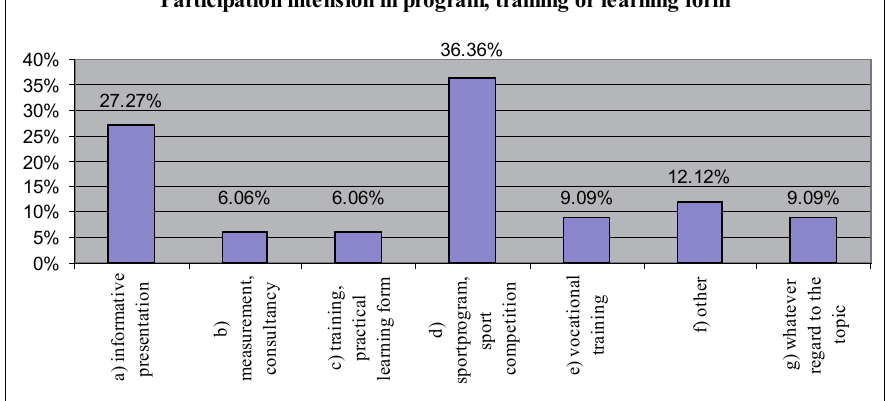
Figure 1. Respondents’ participation intension in program, training or learning form Source: